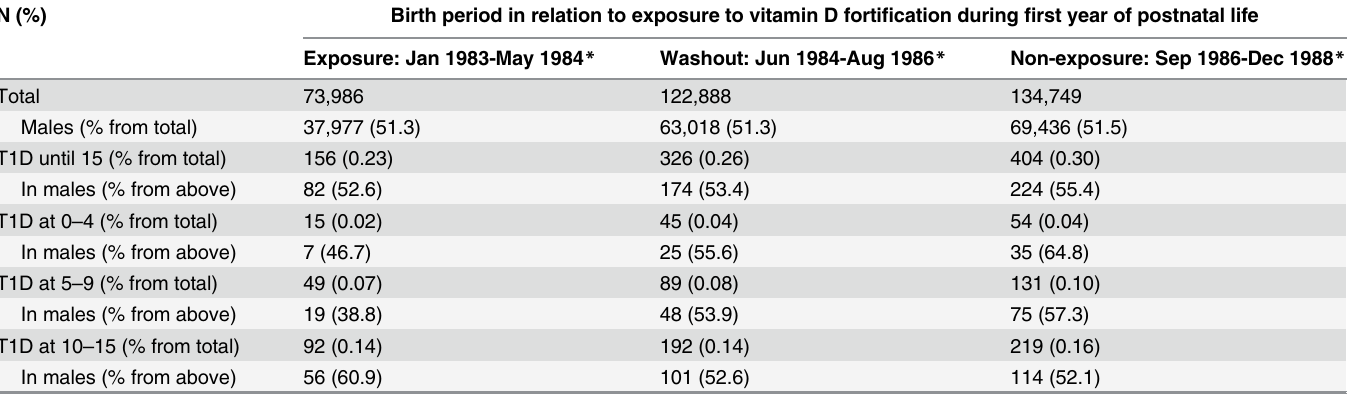
Table 2. Studied population by periods of various first postnatal year exposures to vitamin D fortification, T1D onset age, and sex. N